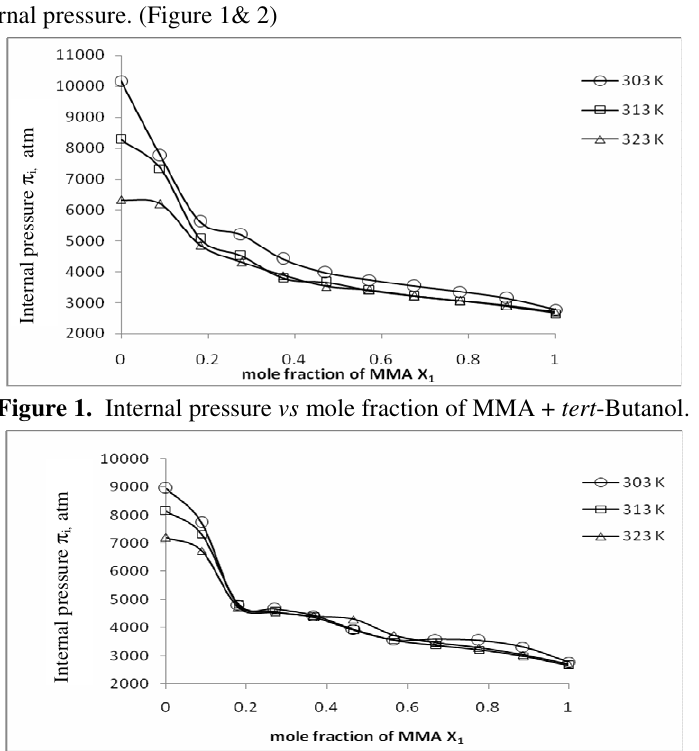
Figure 1. Internal pressure vs mole fraction of MMA + tert -Butanol.